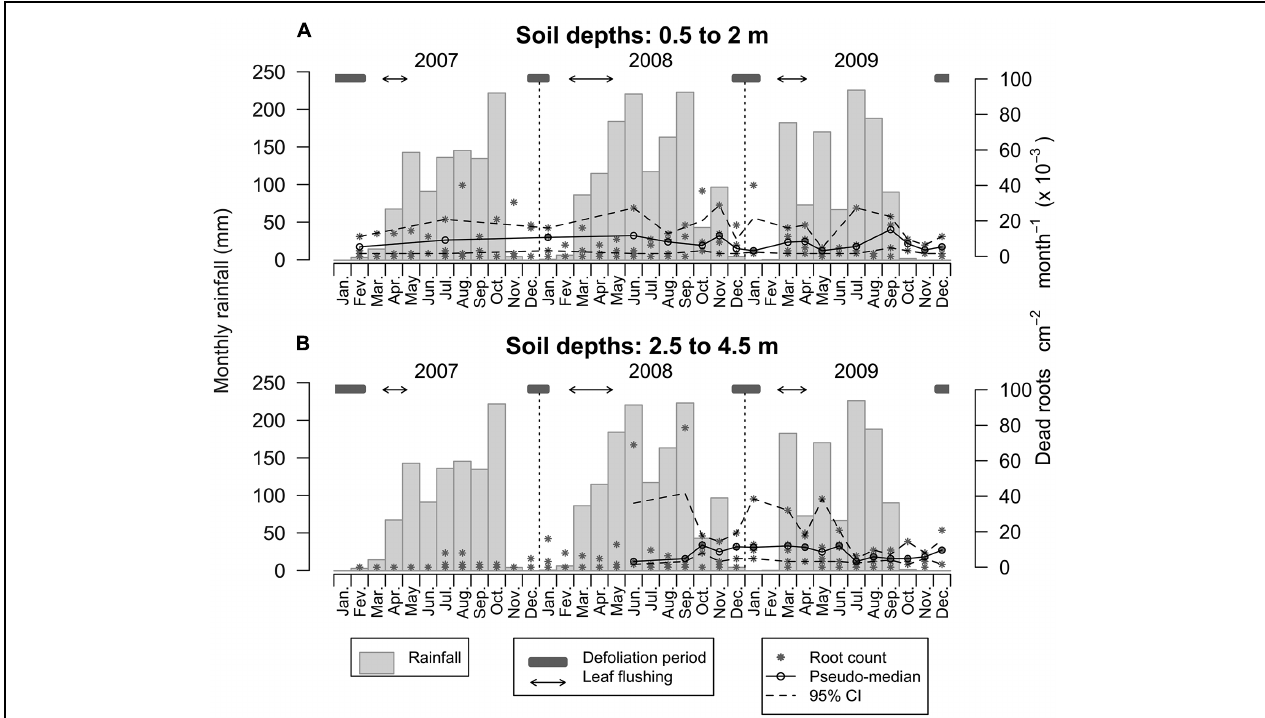
FIGURE 7 | Dynamics of root mortality over 3 years within the top 0.5–2.0m of the soil profile (A) and between 2.5 and 4.5 m (B). Asterisks are emerging root counts determined in every root window at monthly intervals. Open circles represent the pseudo-median of dead root counts in the deeper root windows ( n = 4 and n = 5 for the upper and lower plots, respectively) and dashed lines are 95% confidence intervals estimated using the Wilcoxon signed rank